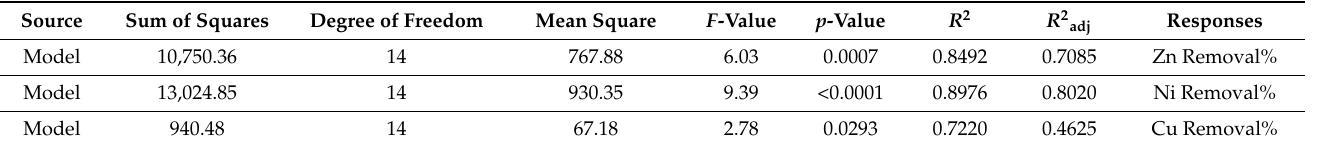
Table 5. ANOVA analysis for the EC